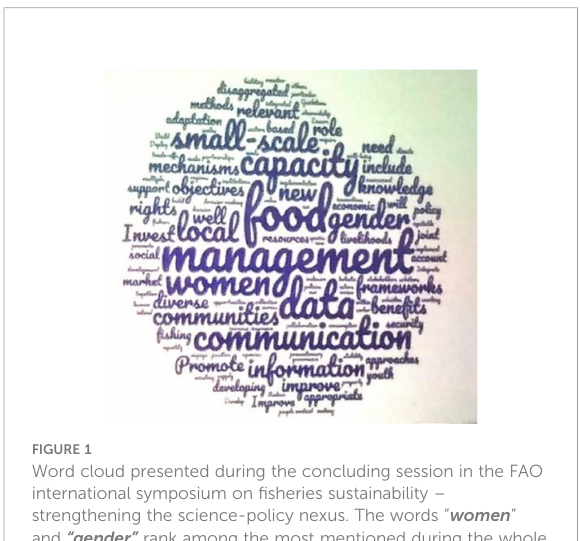
FIGURE 1 Word cloud presented during the concluding session in the FAO international symposium on fi sheries sustainability – strengthening the science-policy nexus. The words “ women ” and “ gender ” rank among the most mentioned during the whole event. Nov. 21 st ,